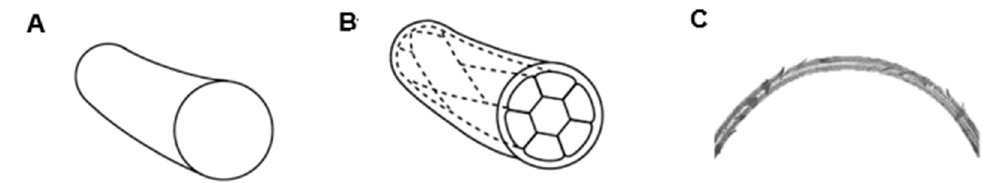
Figure 1. Typical suture threads used in surgical procedures. ( A ) Smooth mono fi lament suture; ( B ) braided multi fi lament suture; ( C ) plurality of barbs on the periphery of a mono fi lament suture. ( B ) braided multifilament suture; ( C ) plurality of barbs on the periphery of a monofilament